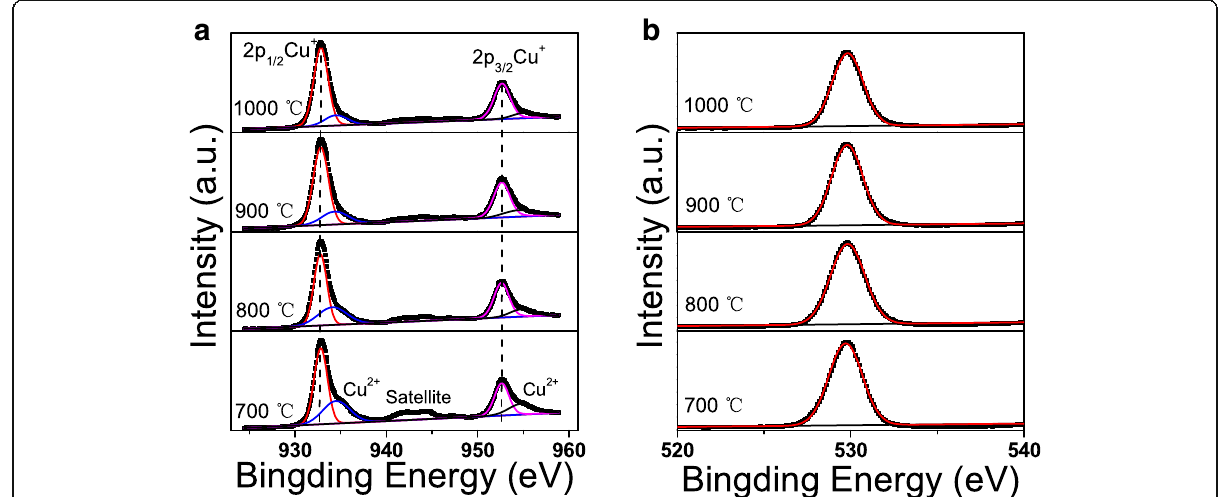
Fig. 2 a Cu 2p. b O 1s XPS spectra of the CuAlO 2 thin films annealed at different